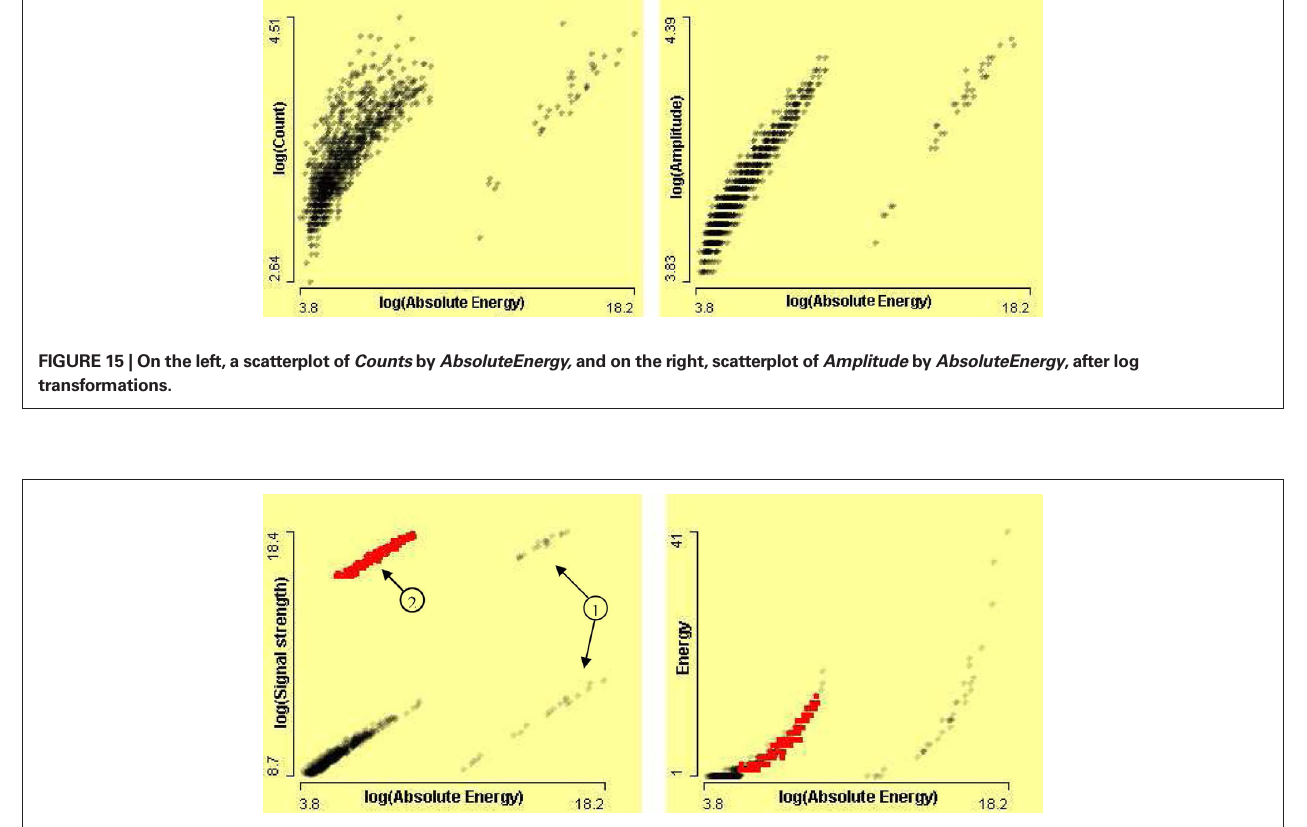
FIgurE 16 | On the left, scatterplot of SignalStrength by AbsoluteEnergy after log transformations, and on the right, scatterplot of Energy by AbsoluteEnergy after log transformation of absolute